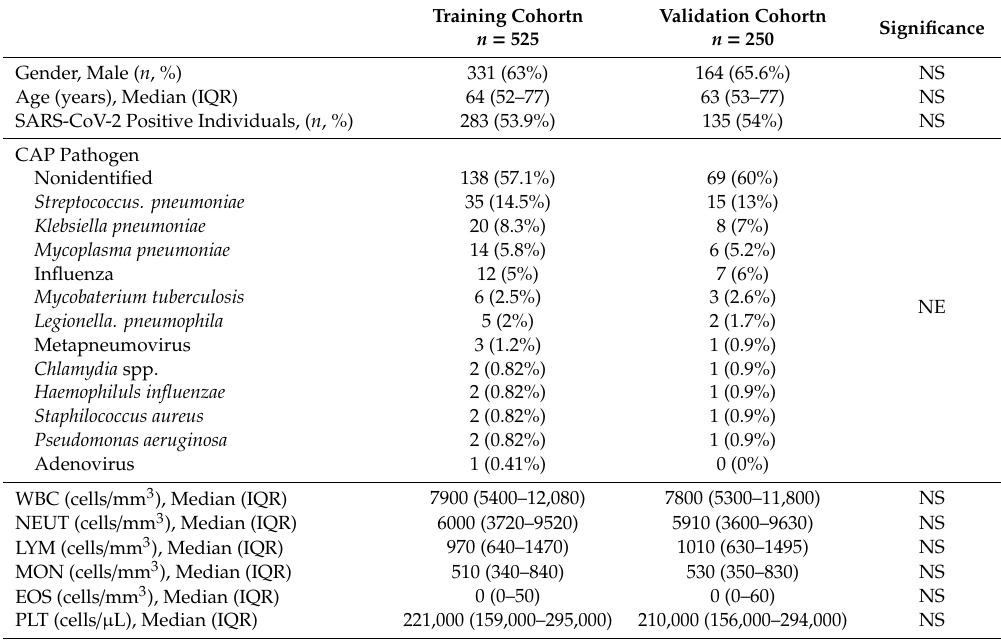
Table 1. Demographics and laboratory characteristics among patients in the training and validation cohort. As auspicated, there was no statistically significant di ff erence between the two cohorts.